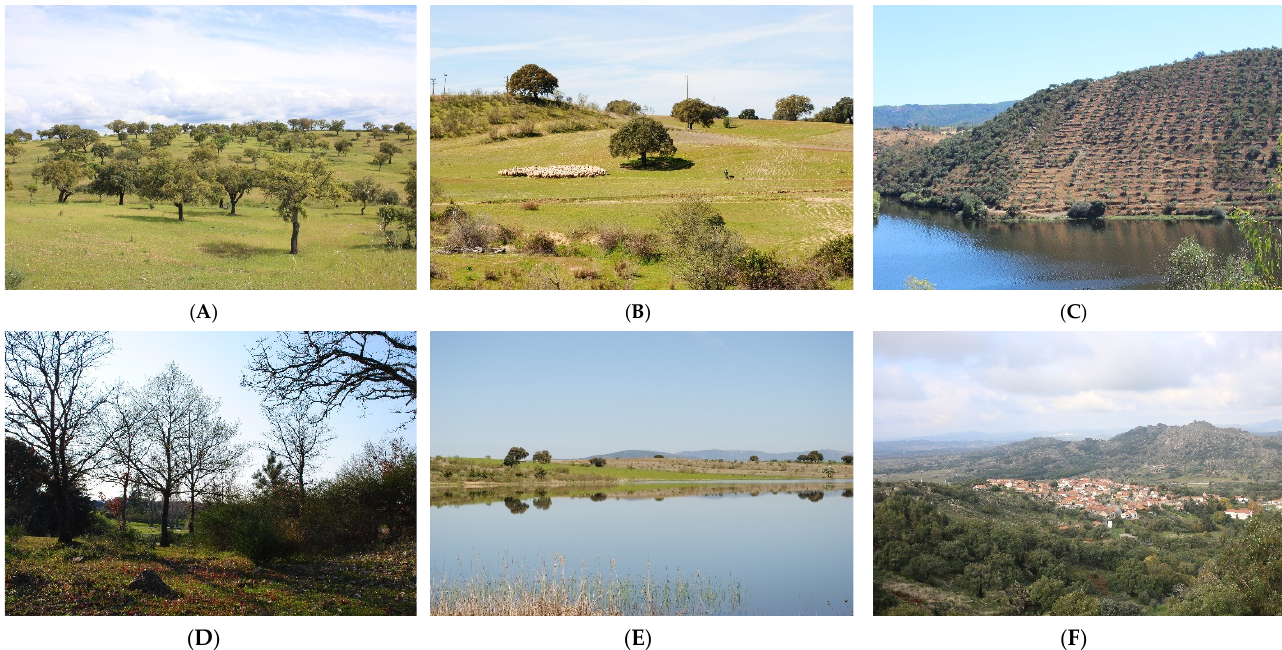
Figure 4. Representative pictures of the most common landscapes typologies at the study area used to evaluate the preferences (photographs). ( A ) Dehesa/Mounted (Photo was taken on spring of 2019); ( B ) Dehesa/Mounted with stockbreeding (Photo was taken on spring of 2019); ( C ) Traditional Olive grove (Photo was taken on summer of 2019); ( D ) Forest and scrubland (Photo was taken on winter of 2019); ( E ) Rivers and water bodies (Photo was taken on summer of 2019); ( F ) Rural settlements (Photo was taken on autumm of